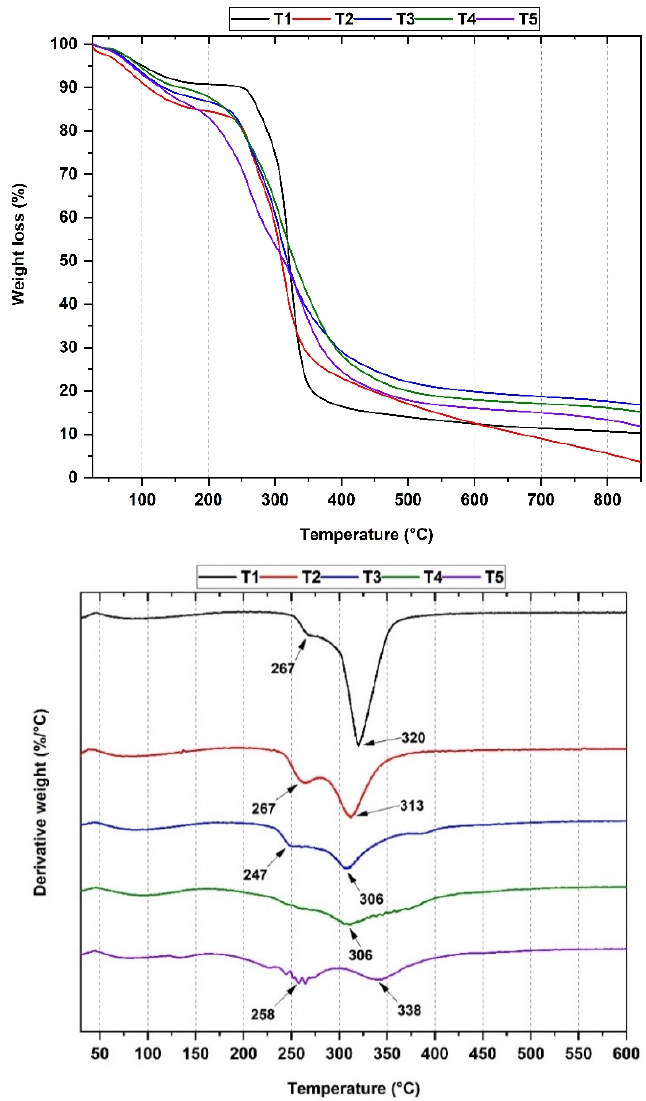
Figure 2. ( A ) Thermal degradation for the composite membranes. ( B ) Derivative of the thermal degradation of the composites. T1 (100%CS); T2 (25%G:75%CS); T3 (50%G:50%CS); T4 (75%G:25%CS); T5 (100%G).